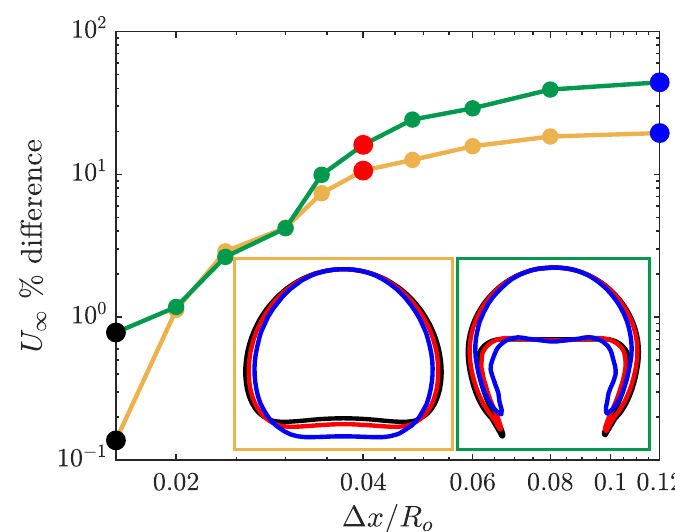
Figure 2. Mesh convergence study for a spherical and skirted rising bubble using the simple coupled level set (LS) and volume of fluid (VOF) (s-CLSVOF) solver in a non-reactive medium. The main figure presents the percent difference in the bubble terminal velocity with respect to the terminal velocity at ∆ x / R o = 0.0125 for a spherical (yellow) and skirted (green) bubble. The two insets at the bottom right present the bubble interface for different mesh resolution: Coarse mesh ( ∆ x / R o = 0.12, blue), medium mesh ( ∆ x / R o = 0.04, red), and fine mesh ( ∆ x / R o = 0.016,